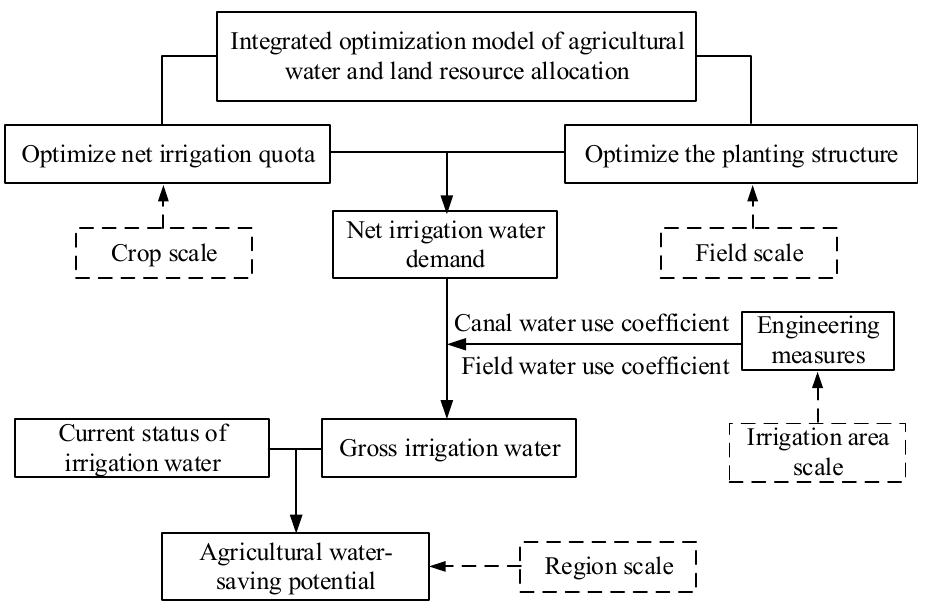
Figure 7. Region water-saving potential calculation flow chart.